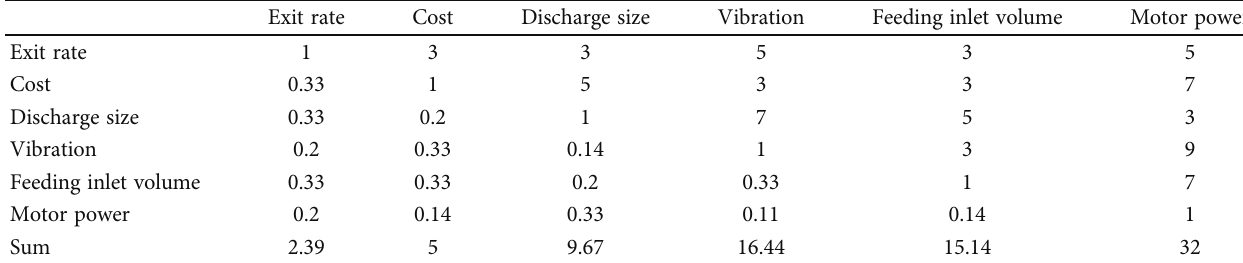
Table 3: Criteria comparison matrix.